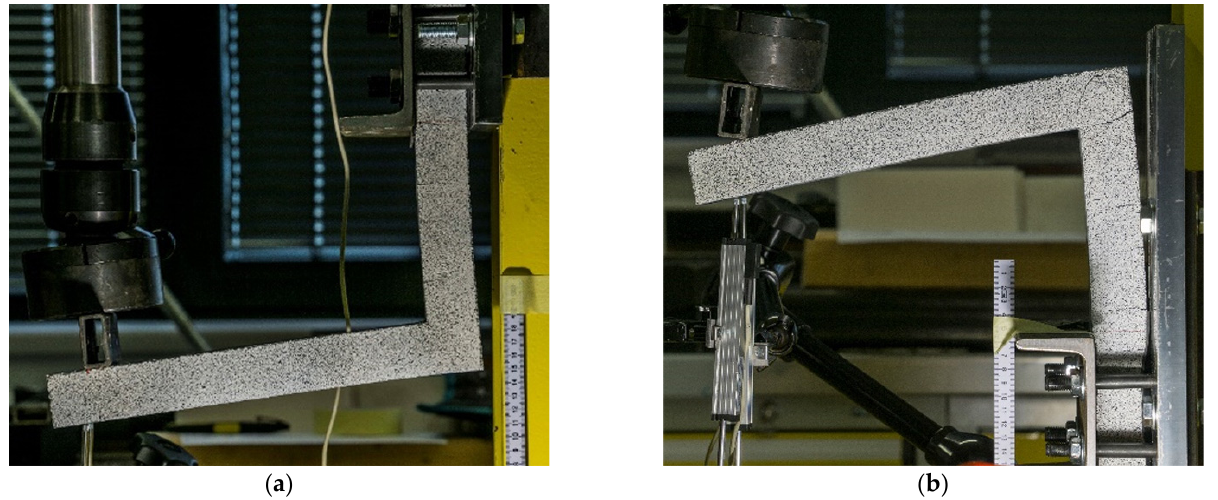
Figure 12. Opening of the rigid frame ( a ) and closing of the rigid frame ( b ).